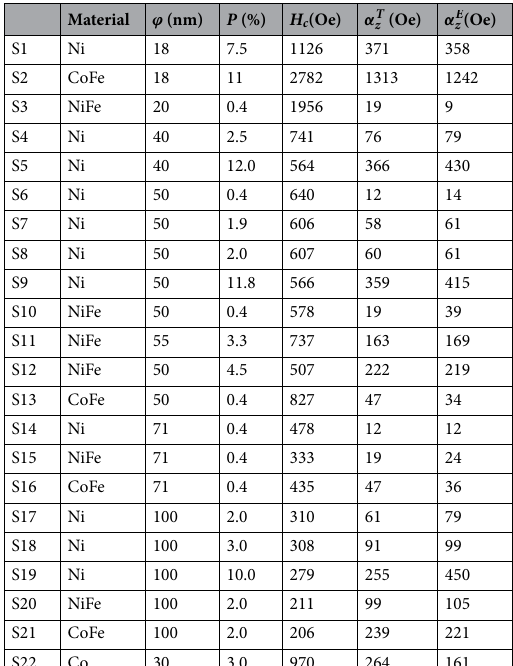
Table 1. List of characterized samples. For each sample the following quantities are: sample number, material, the pore diameter ϕ , the packing fraction P , the coercive field H c , theoretical value of the interaction field α E and the dipolar interaction coefficient α z obtained from the IRM and DCD remanence